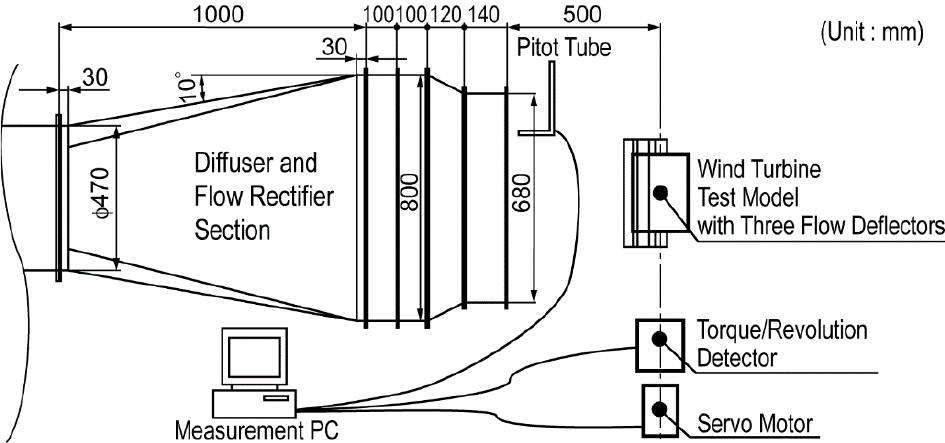
Figure 5. Schematic of output performance test equipment and the test section.